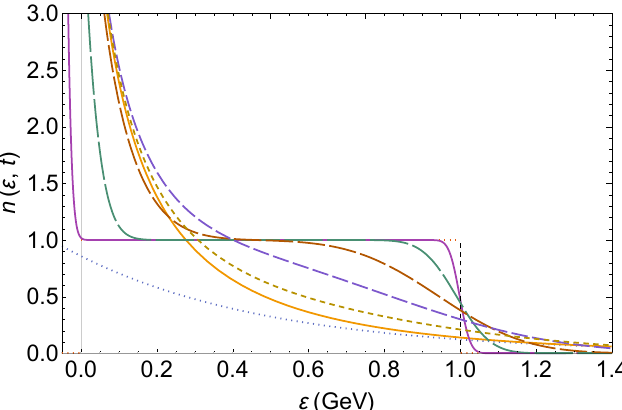
Figure 3. Local thermalization of gluons as represented by time-dependent solutions of the nonlinear boson diffusion equation (NBDE) for µ < 0. Starting from schematic initial conditions Equation(13) in the cold system at t = 0 (box distribution with cut at (cid:101) = Q s = 1 GeV), a Bose–Einstein equilibrium distribution with temperature T = 513 MeV (lower solid curve) is approached. Time-dependent single-particle occupation-number distribution functions are shown at t = 6 × 10 − 4 , 6 × 10 − 3 , 0.04, 0.12, and 0.36 fm/ c (decreasing dash lenghts). The lower dotted curve is Boltzmann’s